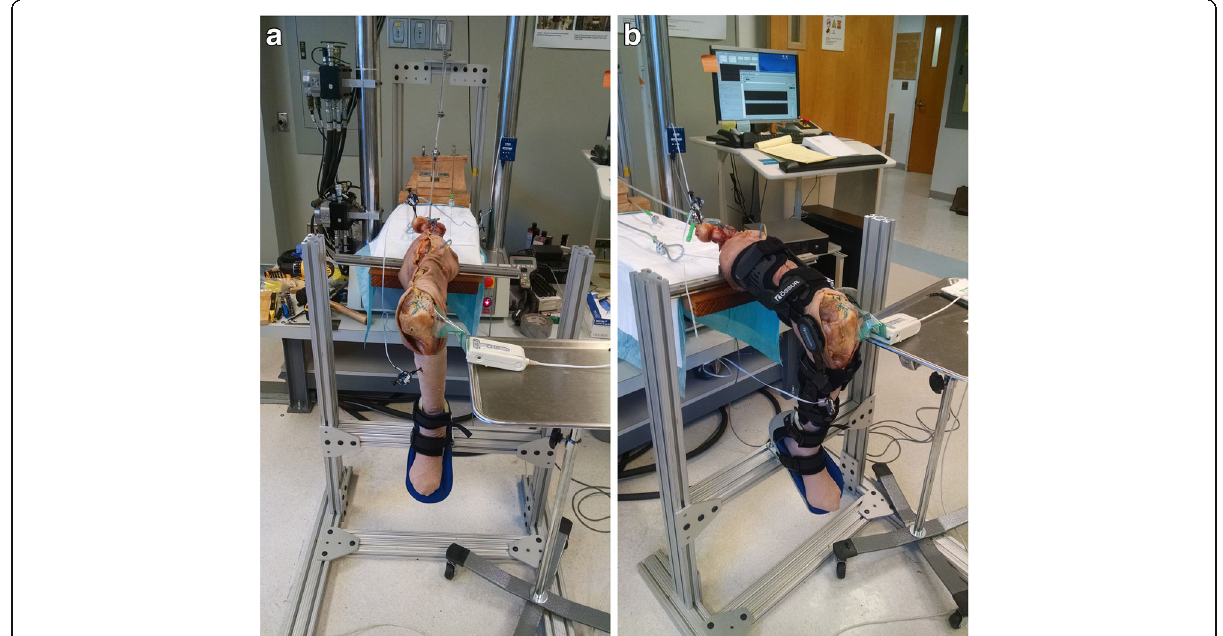
Fig. 1 Photographs of design apparatus with cadaveric knee without ( a ) and with ( b ) application of the dynamic brace. Tekscan sensors connected to the handle via a lateral arthrotomy. Weights are attached to suture pulleys to simulate muscle loading through the hamstrings. The quadriceps is attached to the MTS machine via suture to simulate muscle